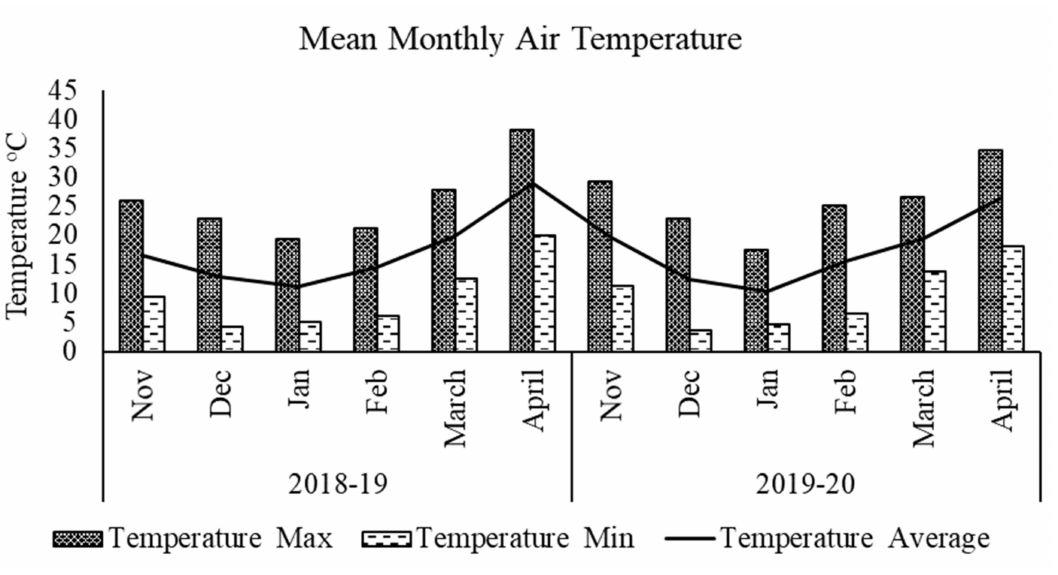
Figure 1. Monthly maximum, minimum, and average temperatures during crop growing seasons (2018–2019 and 2019–2020).